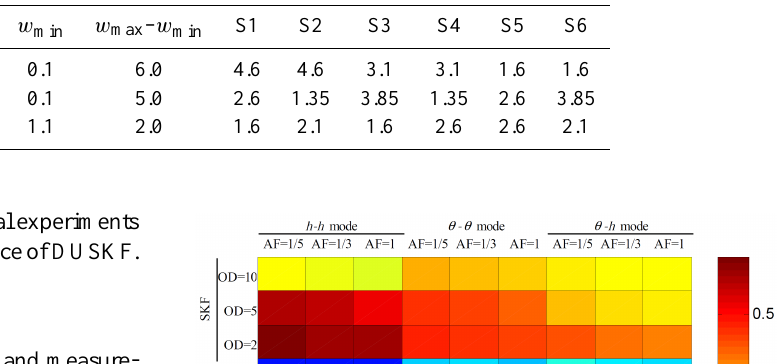
Table 1. Values of the true parameters K s , α and n , the minimum, w min , and the range, w max – w min , used to constrain their distribution, and the resulting six sets of input values considered during the assimilation process.